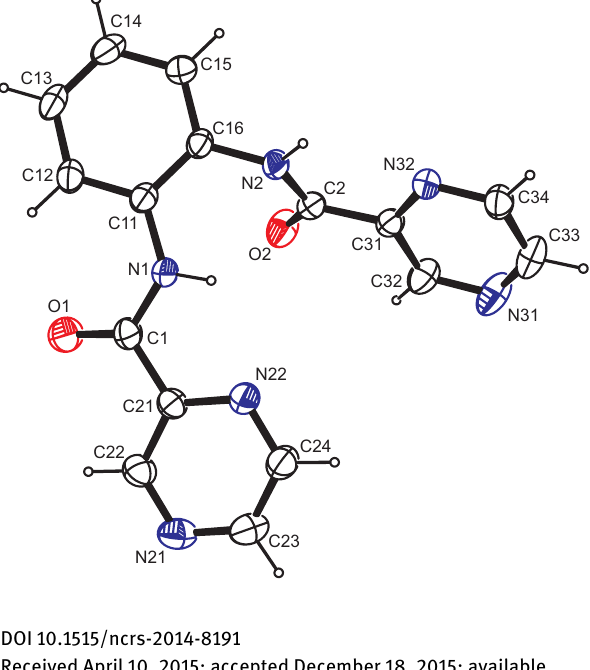
Table 1: Data collection and handling.